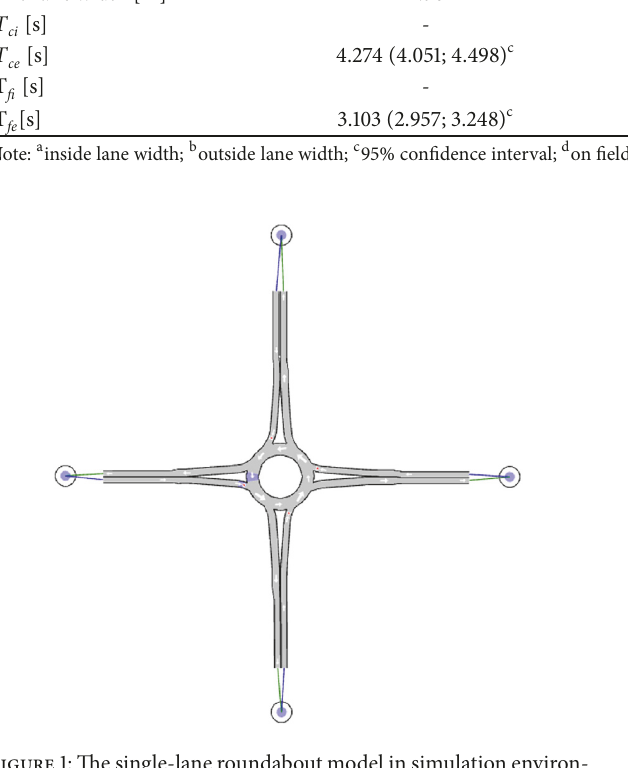
Figure 1: The single-lane roundabout model in simulation environ- ment.